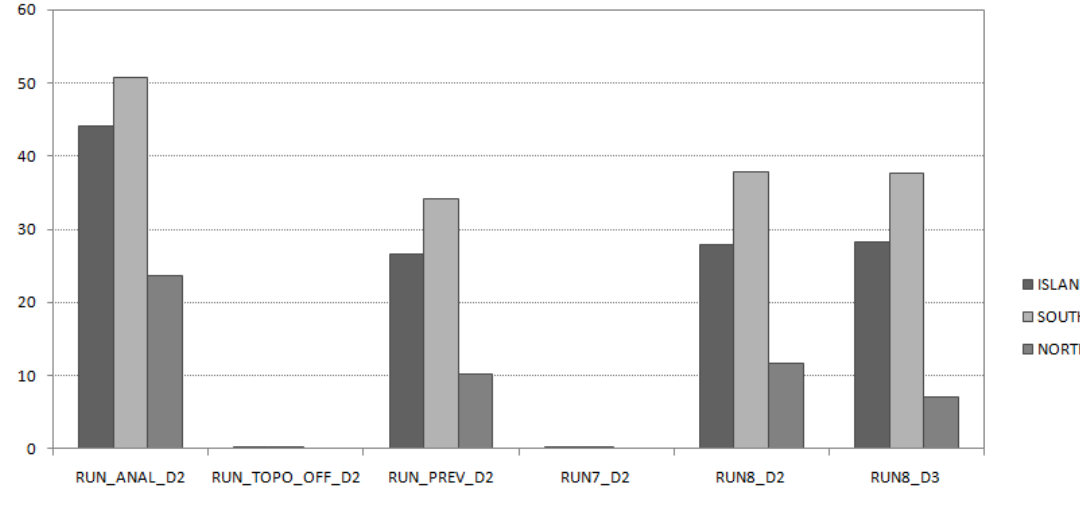
Fig. 7. Percentage of total daily precipitation explained by convective precipitation for locations below 800m.